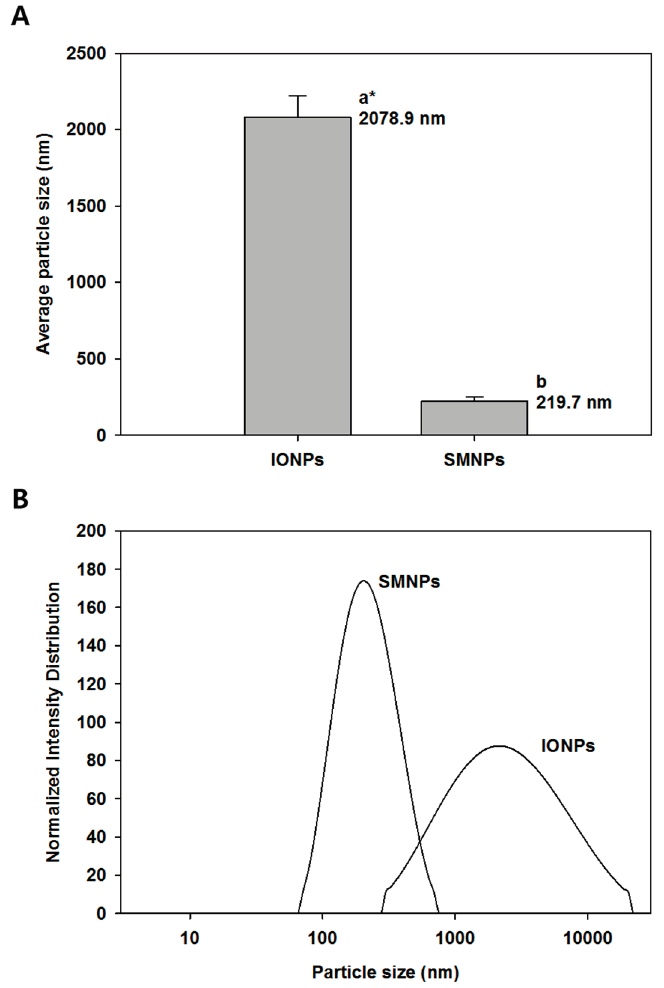
Figure 1. Particle size and size distribution of surface-modified nanoparticles (SMNPs) and iron oxide nanoparticles (IONPs): average particle size ( A ) and normalized size distribution based on intensity of the scattered light ( B ). SMNPs were prepared by surface modification of the IONPs using a citrate functionalization method [16]. * Different letters indicate significant differences in mean values ( p <